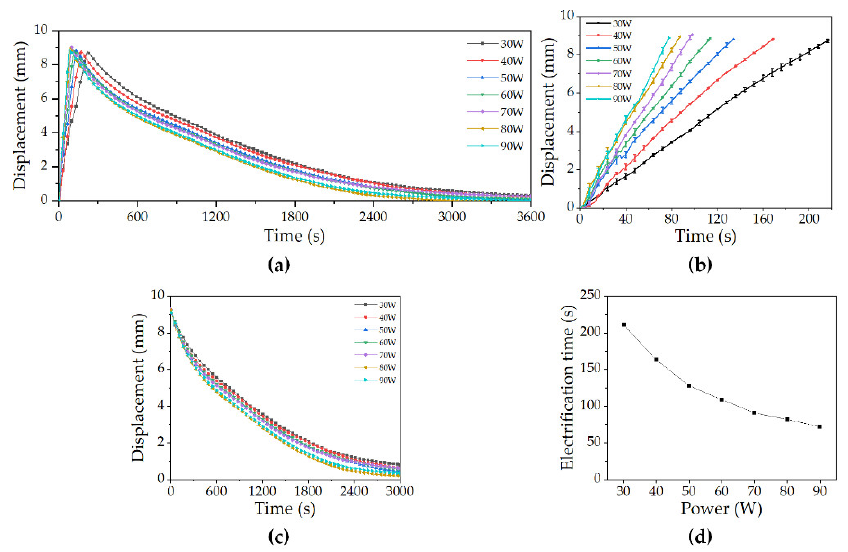
Figure 7. Experimental results of DDM in air: ( a ) Displacement change monitoring of the DDM under different power values, ( b ) displacement change monitoring of DDM running under different power values, ( c ) displacement change data of the microunit during working withdrawal within 3000 s after stopping heating, and ( d ) response time of DDM in air.